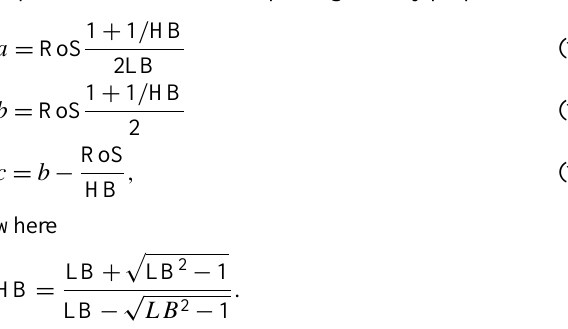
constant 0.397 is a modification of Anderson’s original for- mula to ensure that the fire expands circularly (LB = 1) un- der no-wind conditions ( U =